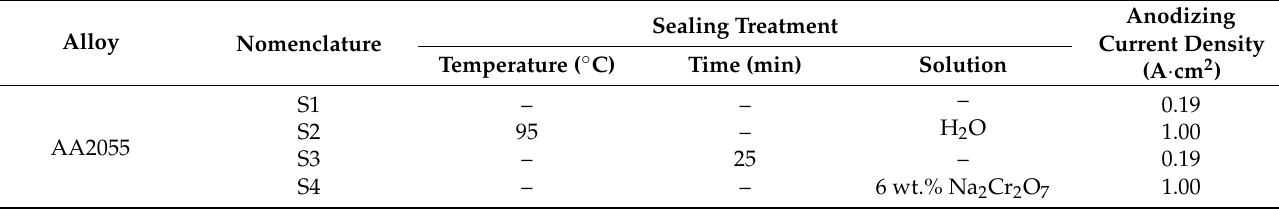
Table 2. Nomenclature and anodizing conditions of different